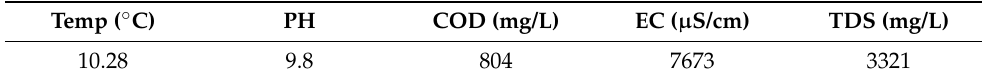
Table 2. Selective characteristics of the raw textile e ffl uent.